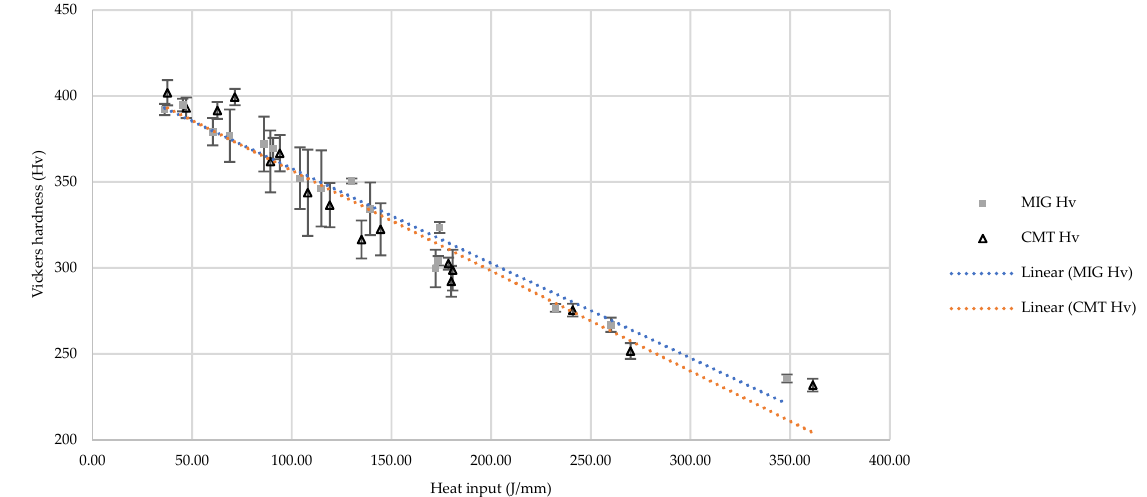
Figure 5. Hardness values of samples plotted against corresponding calculated heat inputs.